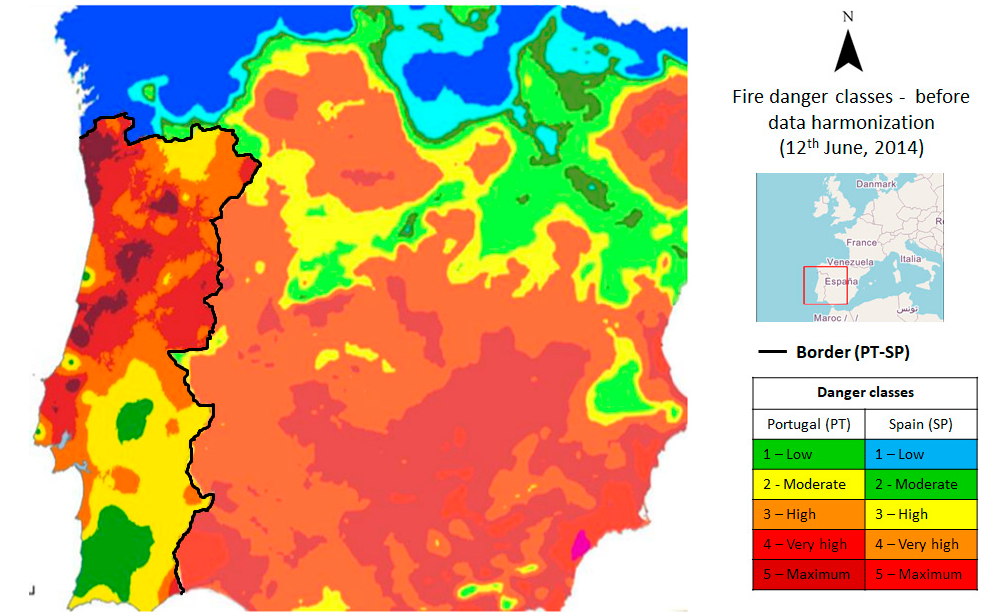
Figure 1. Classification of the fire danger classes based on FWI in Portugal (PT) and Spain (SP) in 12 June 2014. The black line represents the border between PT and SP.